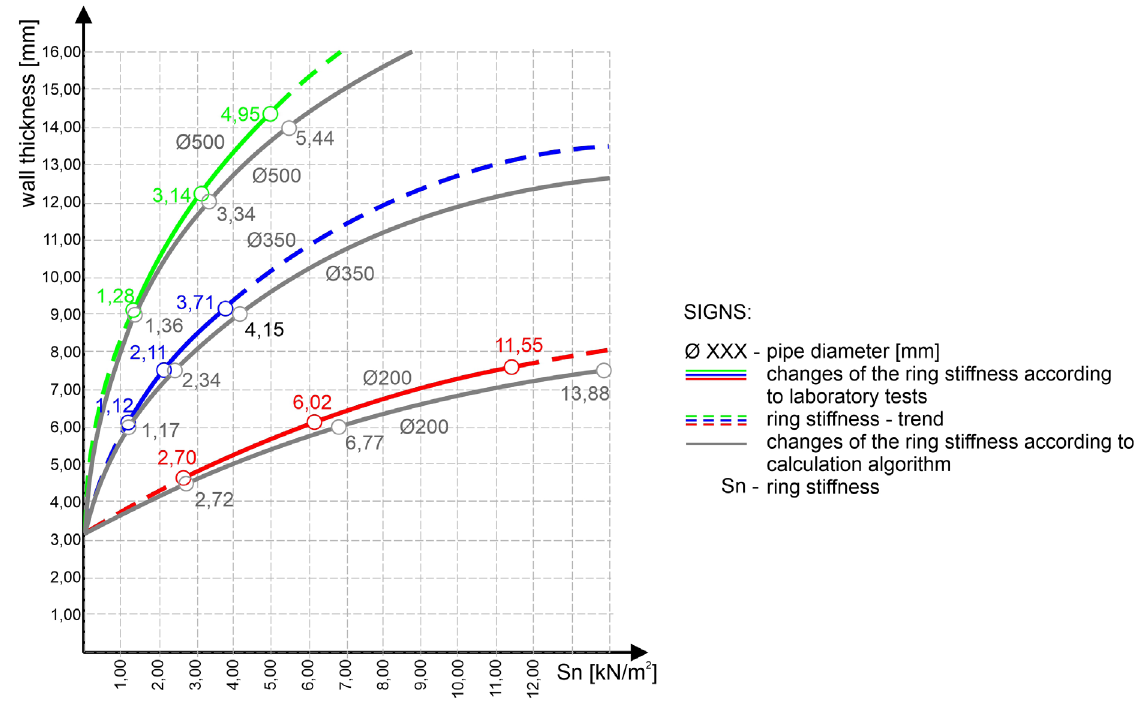
Figure 16: Real and computational ring stiffness for different